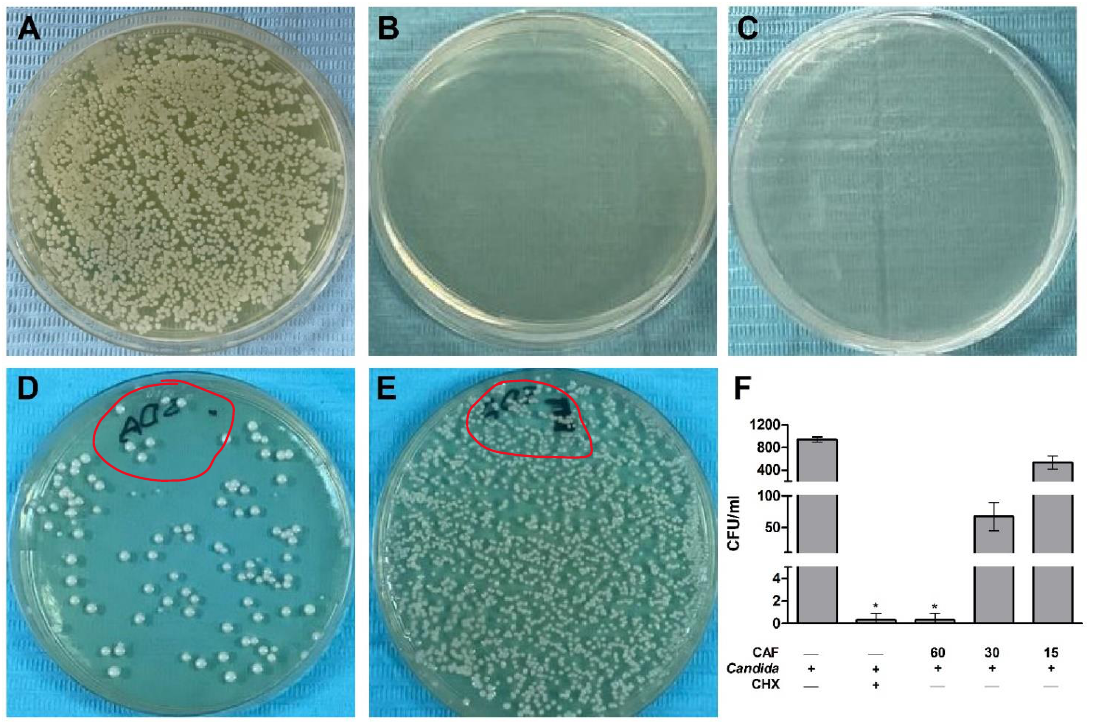
Figure 2. Antifungal Susceptibility Assay of caffeine (CAF) against C. albicans growth. ( A ) Fungal cell overgrowth in control group (PBS) containing no treatments. ( B ) Complete inhibition of the fungal cell growth in chlorhexidine (CHX) group. ( C – E ) Different concentrations of CAF including 60, 30, and 15 mg/mL, respectively, showing the dose-dependent effects of CAF and the gradual growth inhibition of fungal cells. ( F ) CFU count of different SDA plates. Data are expressed as mean ± SD ( n = 3) and statistically analyzed using Kruskal – Wallis test and Dunn ’ s post hoc test. The significance was considered when * p ≤ 0 .05 as compared with control.